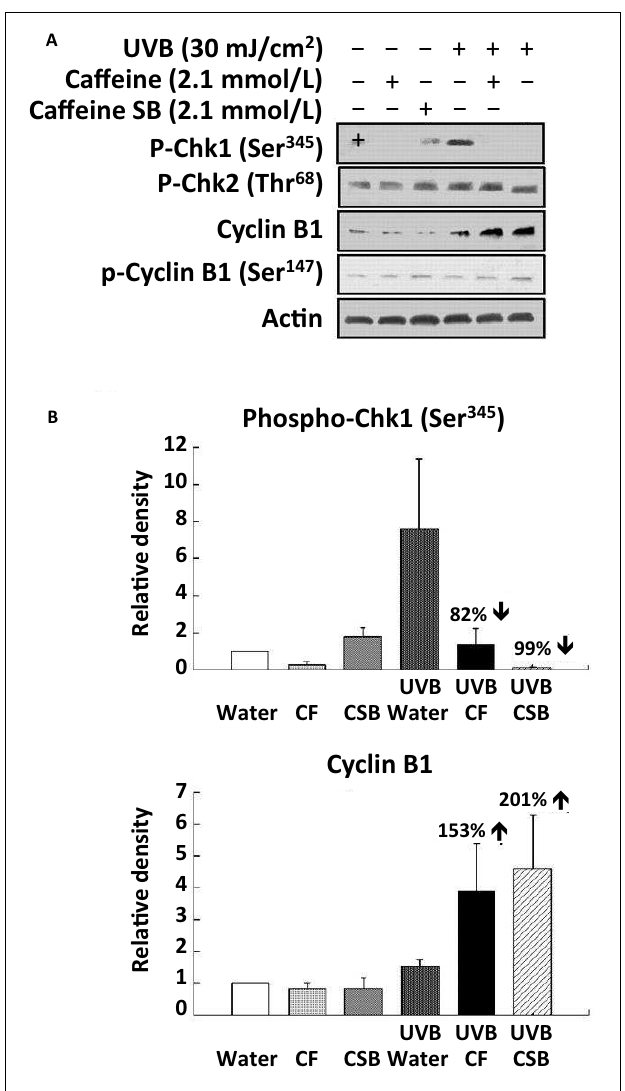
FIGURE 7 | Effects of oral caffeine (CF) or caffeine sodium benzoate on UVB-induced changes in phospho-Chk1 (Ser 345) and cyclin B1 in the epidermis of SKH-1 mice: western blot studies . Female SKH-1 mice were treated p.o. with caffeine (CF; 0.4mg/ml, 2.1mmol/l) or caffeine sodium benzoate (CSB, caffeine-SB; 2.1mmol/l) as their sole source of drinking fluid for 1week.The animals were then treated with UVB (30mJ/cm 2 ) and killed 6h later. In (A) , phospho-Chk1 (Ser345), phospho-Chk2 (Thr68), cyclin B1, and phospho-cyclin B1 (Ser147) were determined byWestern blot. In (B) , the average densitometry results from three independent experiments are shown.Taken from Lu et al.